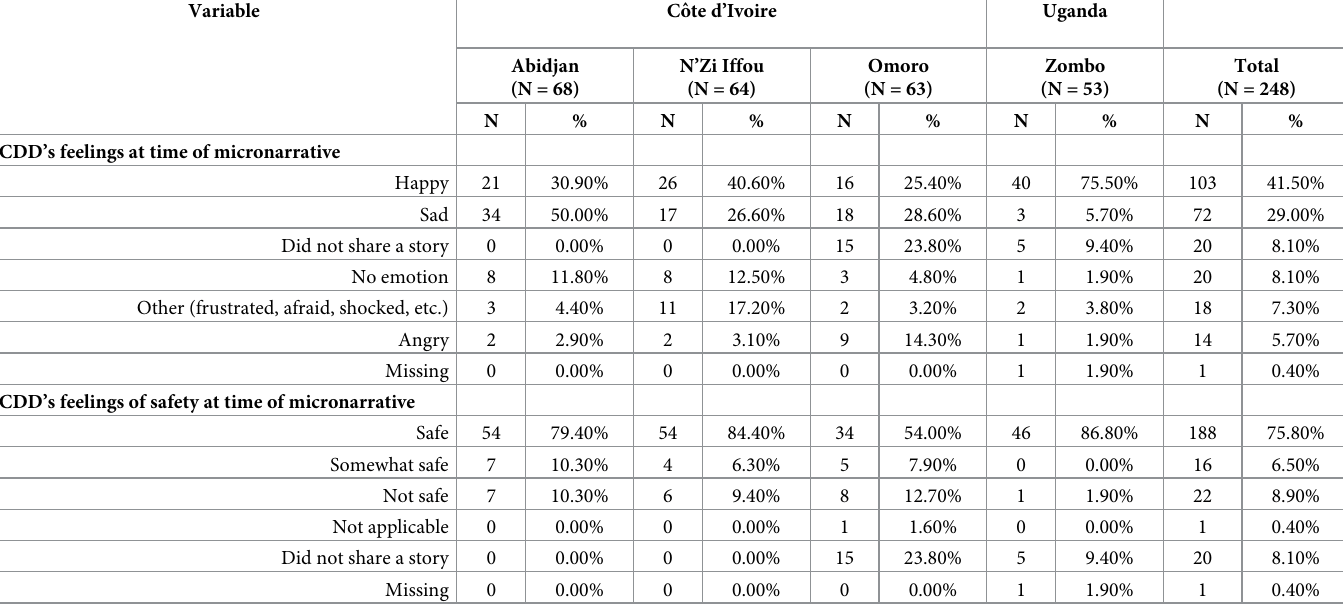
Table 6. CDDs’ feelings at the time of their micronarrative story, by region/district. Variable